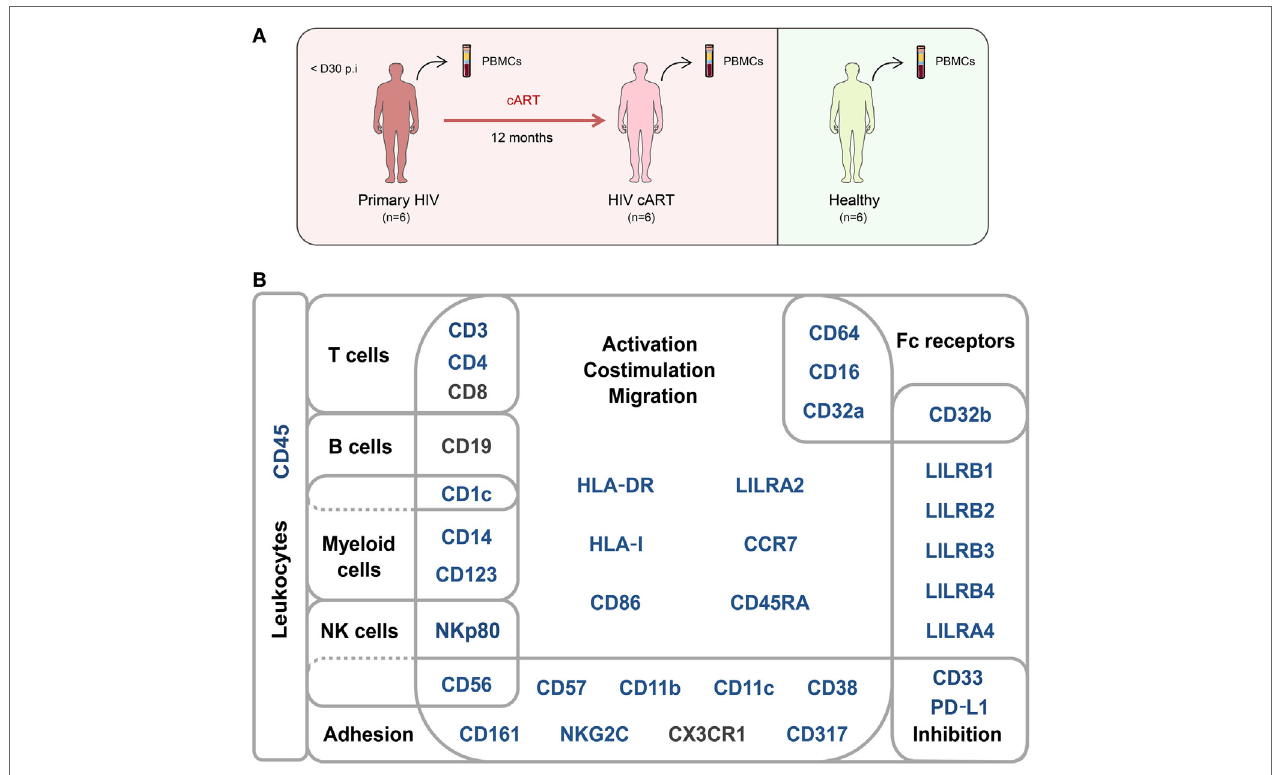
FigUre 1 | Study design and mass cytometry panel. (a) Schematic representation of the study design. Two groups of individuals were studied. The first group corresponds to HIV-infected patients collected during primary HIV infection, diagnosed within 30 days post-infection (primary HIV), and after 12 months of combination antiretroviral therapy (HIV cART). The second group corresponds to healthy donors (healthy). Blood samples were collected from the two groups of individuals and PBMCs isolated for mass cytometry analysis. (B) Pan-leukocyte mass cytometry panel, including 35 parameters, used to characterize CD32a + CD4 + T-cell diversity in leukocytes from PBMC samples. Markers used for Spanning-tree Progression Analysis of Density-normalized Events (SPADE) clusterization of CD4 + T cells are indicated in blue. Non-SPADE clustering markers are indicated in